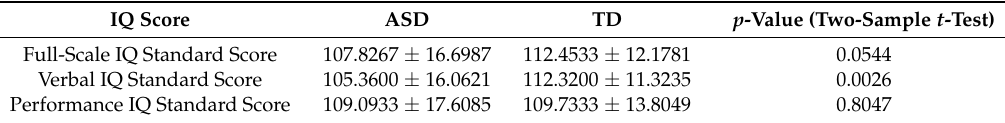
Table 3. Different IQ Scores for ASD and TD subjects. A two-sample t -test has been performed in order to determine the existence of significant differences in any evaluated fields. Results show that there exist differences in Verbal IQ Score between both groups.